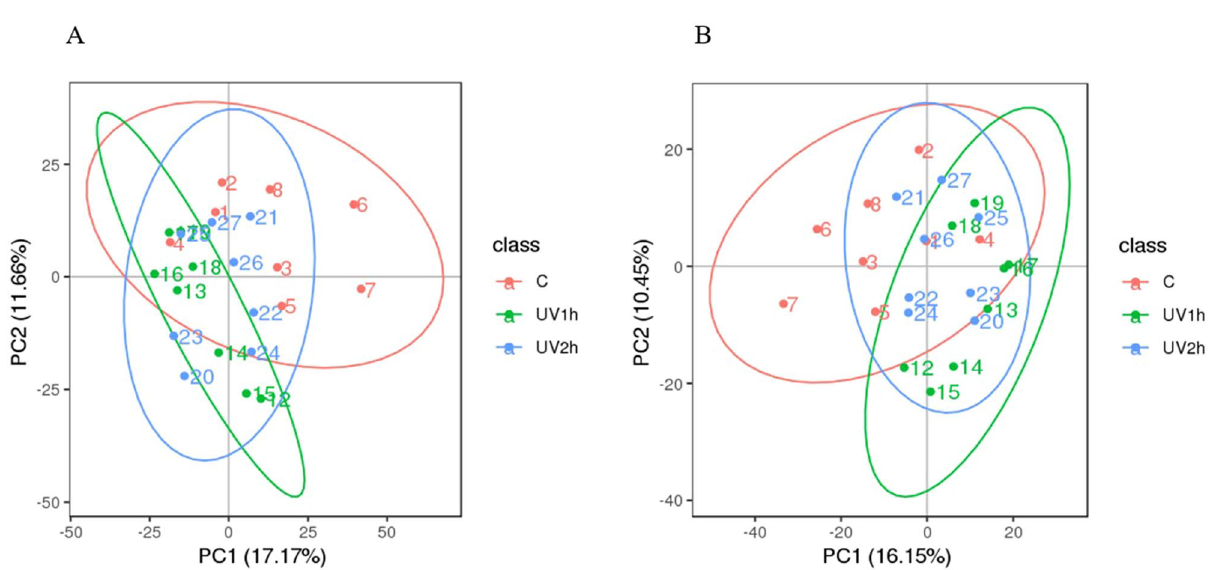
Figure 6. PCA of metabolic profiles of CK, UV1h, and UV2h (eight biological replicates) identified in POS (A) and NEG (B) ion modes. PCA principal component analysis, UV ultraviolet, POS positive, NEG negative, PC1 first principal component, PC2 second principal